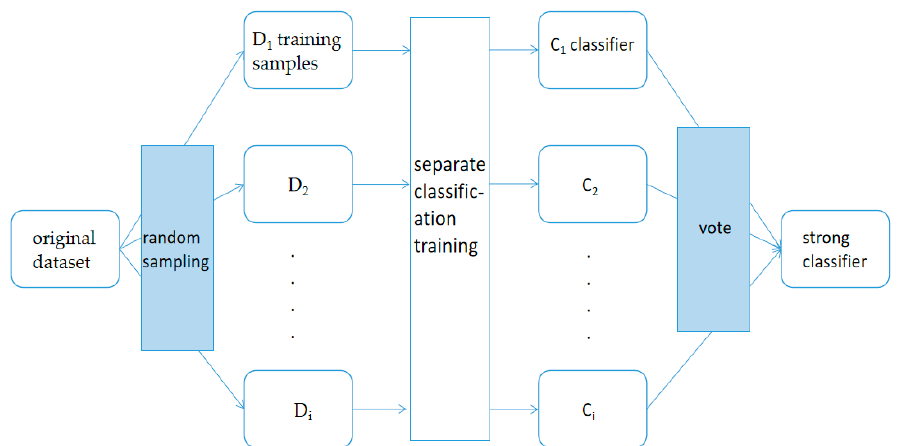
Figure 2. The packet structure of the RF algorithm, by combining multiple weak classifiers into a strong classifier, makes the results have high accuracy.